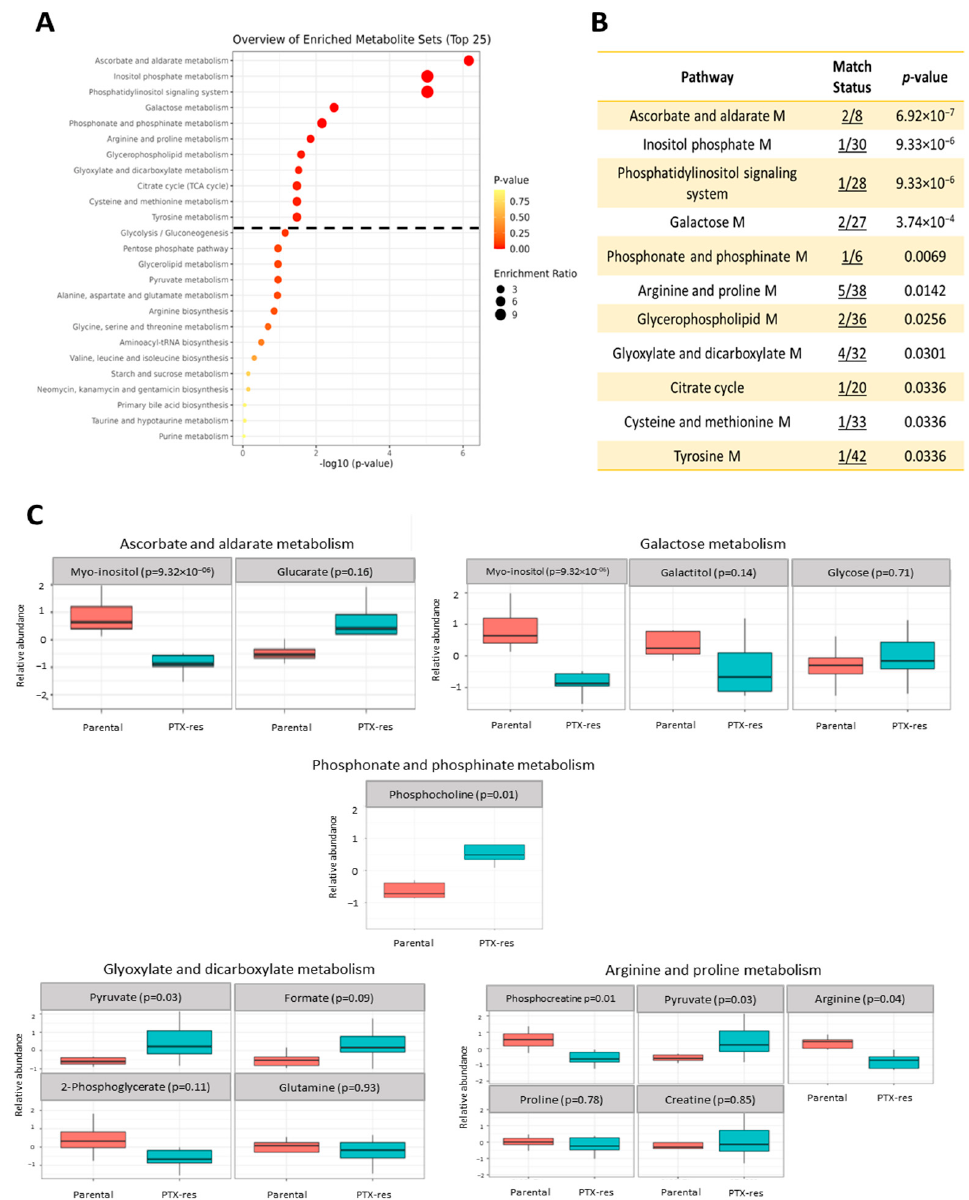
Figure 6. Metabolite enrichment analysis using MetaboAnalyst. ( A ) Quantitative enrichment analysis overview of the enriched metabolite sets derived from the quantified metabolites of parental and PTX-res cells based on the KEGG pathways library. The dashed line represents the cut-off for the significantly enriched metabolite sets in the PTX-res cells ( p < 0.05 and FDR < 0.1). ( B ) Table that summarizes the KEGG metabolism-related pathways that were found enriched in the PTX-res cells. Match status indicates the number of metabolites found in our data vs. the number of metabolites in the library related to a specific pathway. ( C ) Concentration levels of the metabolites associated with the pathways presented in ( B ) in parental and PTX-res cells (M; metabolism).